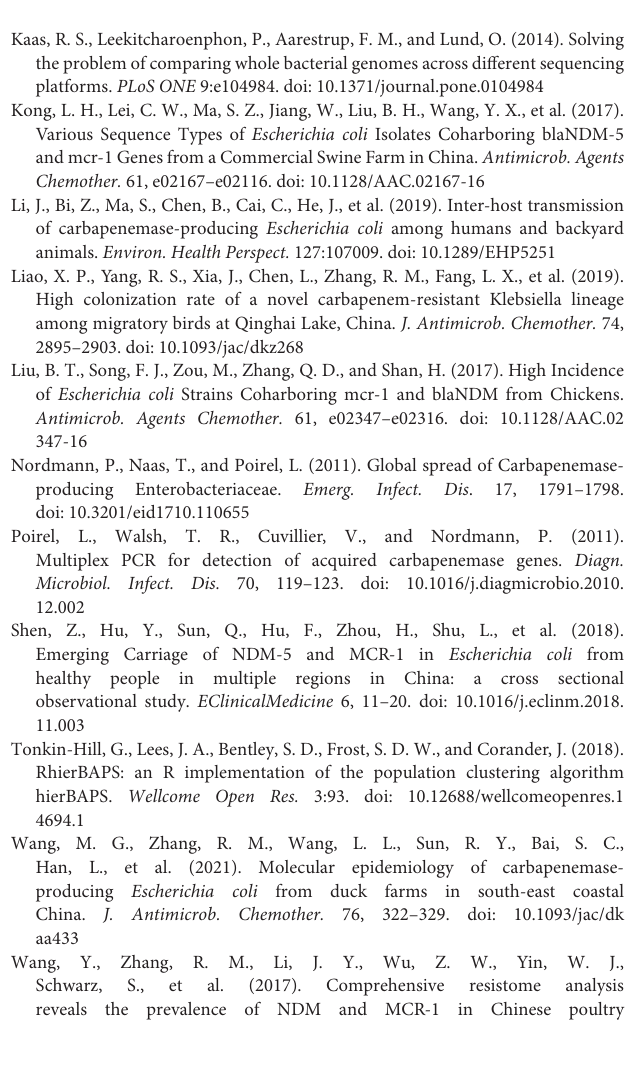
Supplementary Figure 1 | Minimum spanning tree analysis of the cgMLST profiles of 28 isolates. Numbers on lines correspond to the number of target genes for which allelic differences were detected. Circle colors are used to differentiate the city of origin of the isolates. Supplementary Figure 2 | S1-PFGE and hybridization of the plasmids of bla NDM -positive Escherichia coli isolates. Lane M: XbaI-digested genomic DNA of reference Salmonella enterica serotype Braenderup strain H9812, and the bands on membrane represent the plasmids where bla NDM genes are located on. Supplementary Figure 3 | The sequence comparison and map generation of bla NDM -carrying plasmids with reference IncX3 plasmid (Accession Number: KU761328) from an ST25 Klebsiella pneumoniae isolated from human peritoneal fluid in